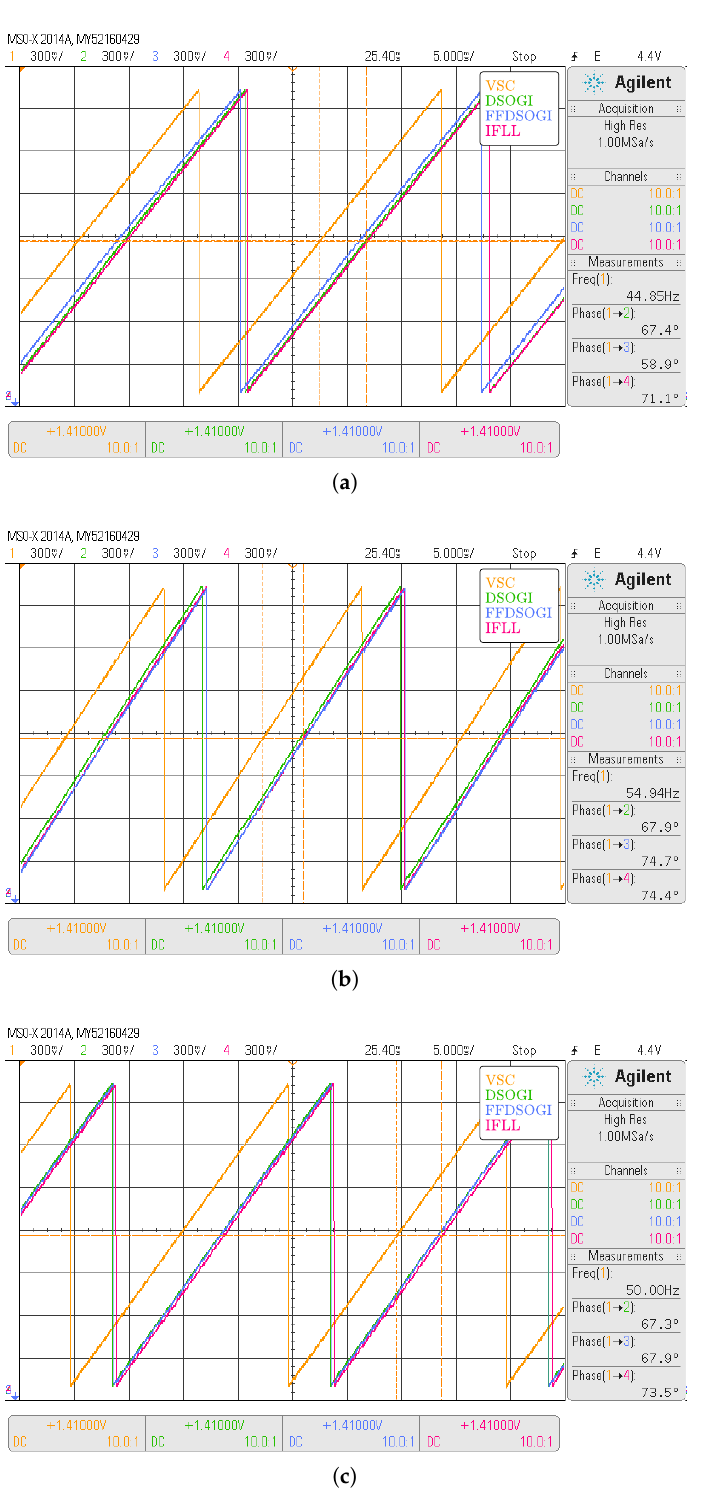
Figure 21. Steady state angle estimation for different frequencies. ( a ) 45 Hz, ( b ) 50 Hz and ( c ) 55